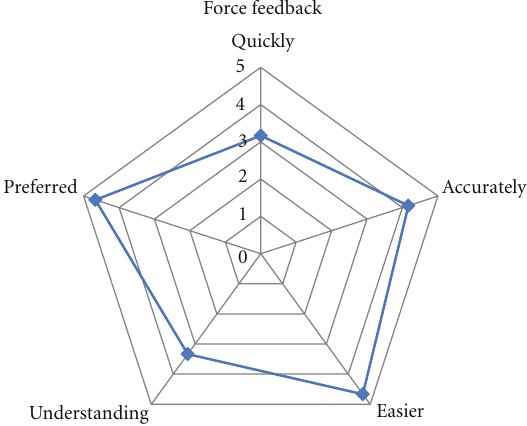
Figure 7: Segmentation questionnaire scores from the subjective feedback.